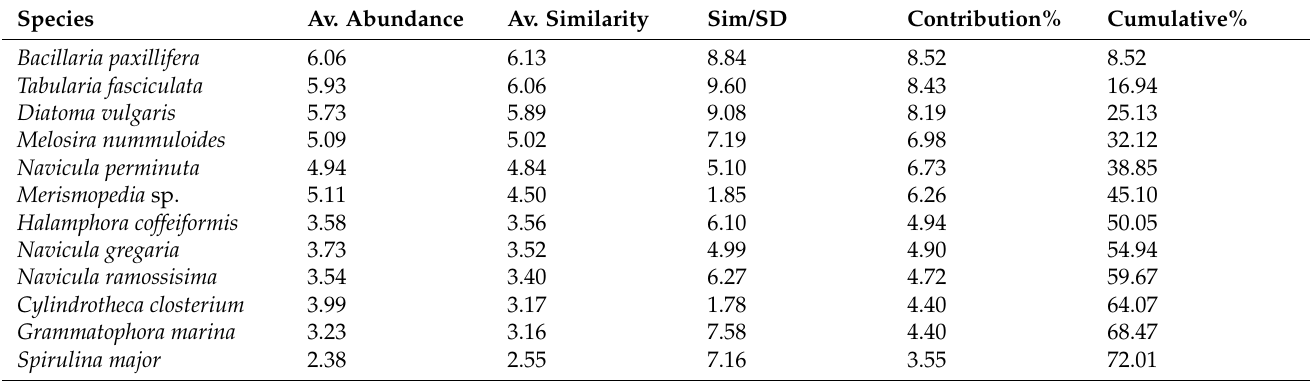
Table A2. Results of the similarity analysis calculated with SIMPER. Average similarity: